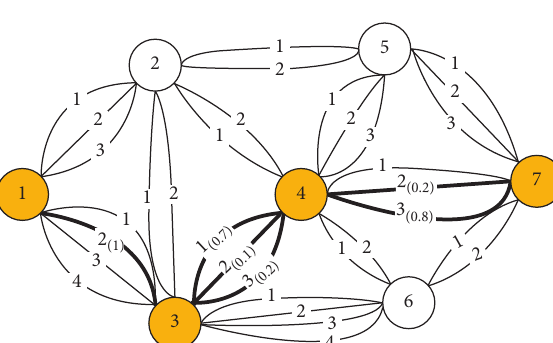
Figure 5: Optimal route scheme for example